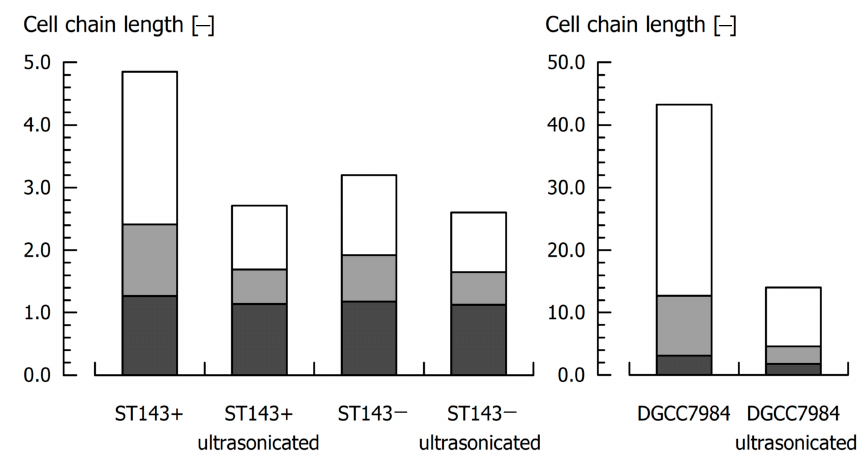
Figure 3. Bacteria cell chain length of S. thermophilus before and after ultrasonic treatment for CPS removal. Dark grey: x 10 ; light grey: x 50 (median); white: x 90 values of the cell chain length distribution.